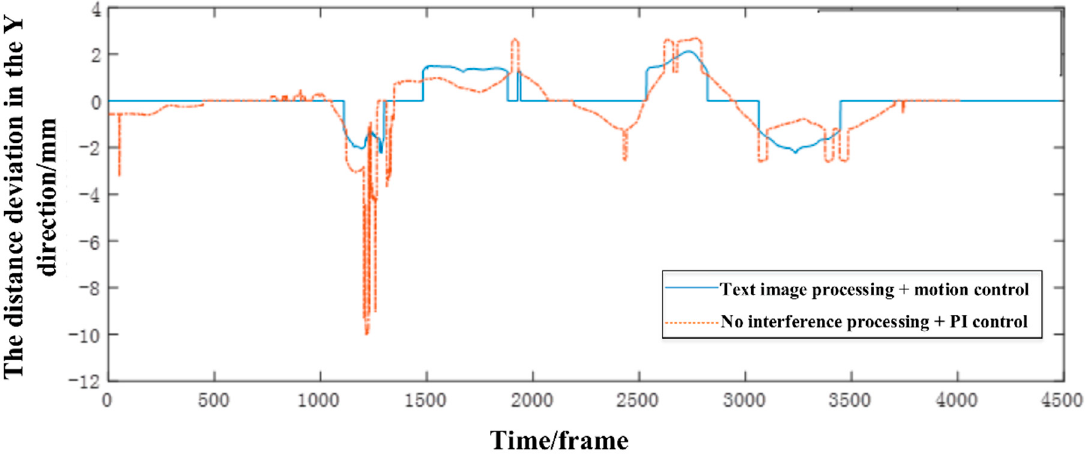
Figure 16. Comparison of real vehicle operation effect under overall algorithm.